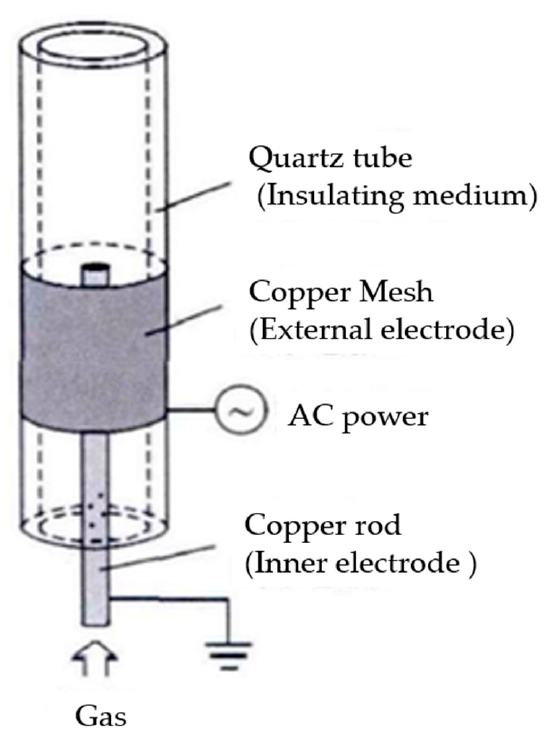
Figure 3. Plasma reactor. The discharge area of the coaxial cylindrical reactor is an air gap between the inner electrode and the inner wall of the quartz tube. When the premixed gas passes through the discharge area, it is ionized by a strong electric field to generate an active signal. As shown in Figure 4, the area between the outer electrode and the inner electrode can be divided into two parts, namely the gas area from the radius r 1 of the inner electrode to the inner diameter r 2 of the quartz tube, where the dielectric constant is close to vacuum, and the inner diameter of the quartz tube r 2 to the quartz tube. The dielectric region of the tube’s outer diameter r 3 , which is an insulating dielectric quartz, has a relative permittivity of ε r =